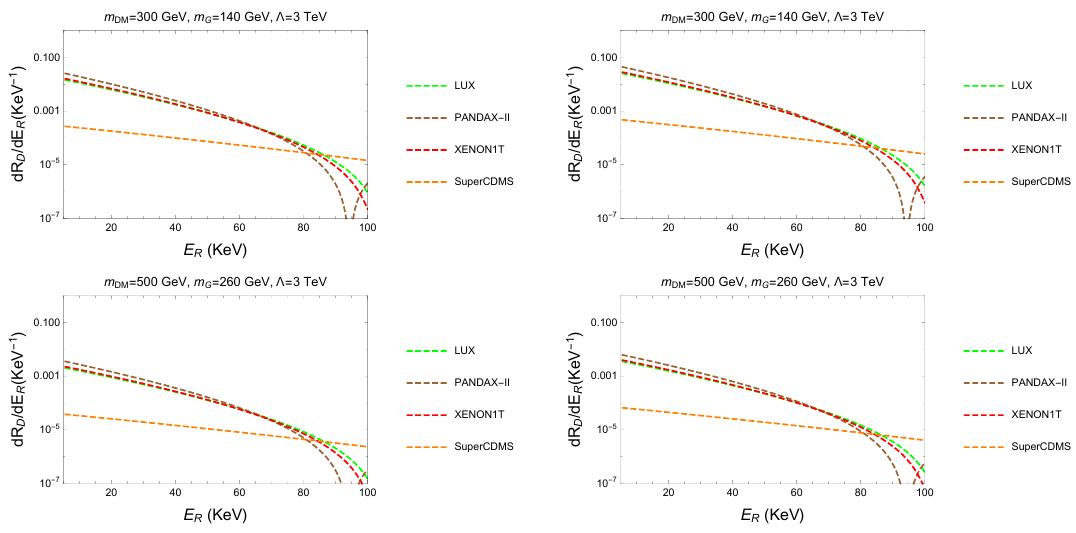
Figure 5 . The same as in (cid:12)gure 4, but with di(cid:11)erent masses for DM and spin-2 mediators and (cid:3) = 3